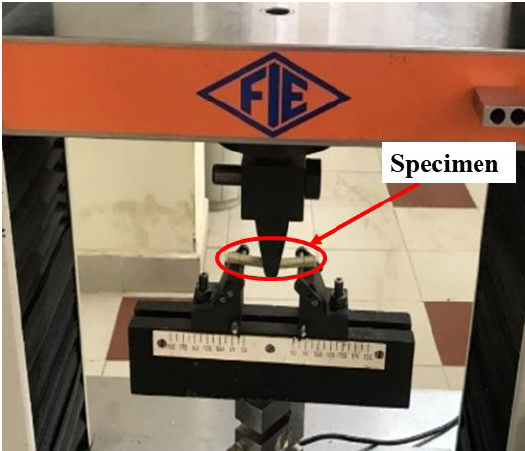
Figure 3. Flexural test setup.